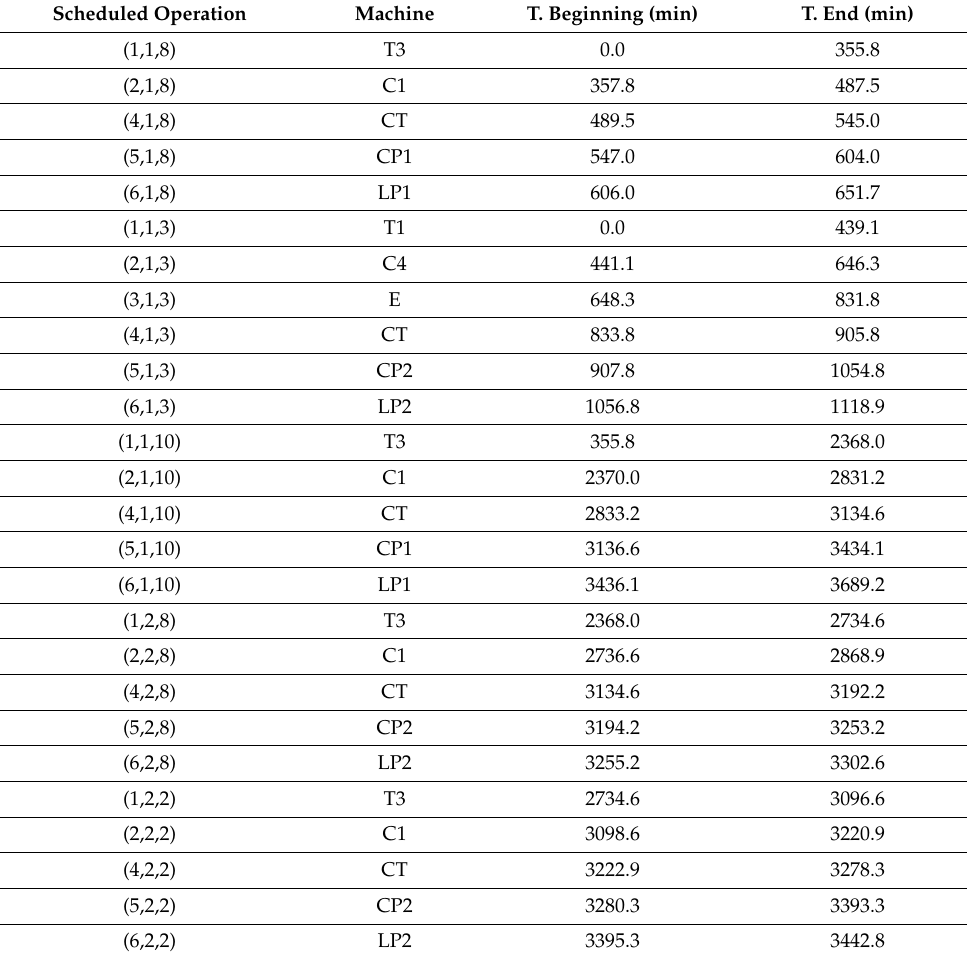
Table A13. Schedule resulting from the DFT